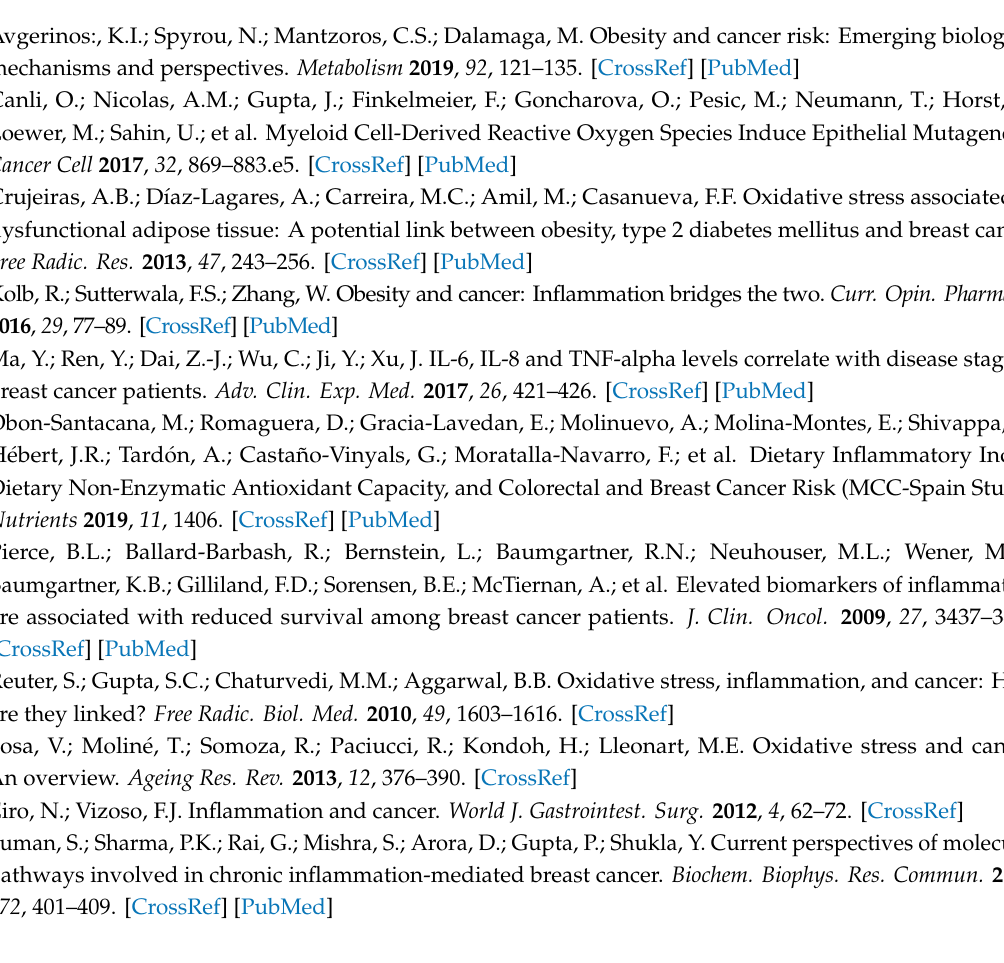
Table S1: Sequence of primers used in qPCR; Table S2: Transcriptional levels of inflammatory markers analyzed Table S3: Plasma antioxidant markers in breast cancer patients undergoing chemotherapy at a university hospital in Uberl â ndia, MG, Brazil, 2014–2015; Table S4: Characterization of women who presented post-treatment metastasis—data obtained in